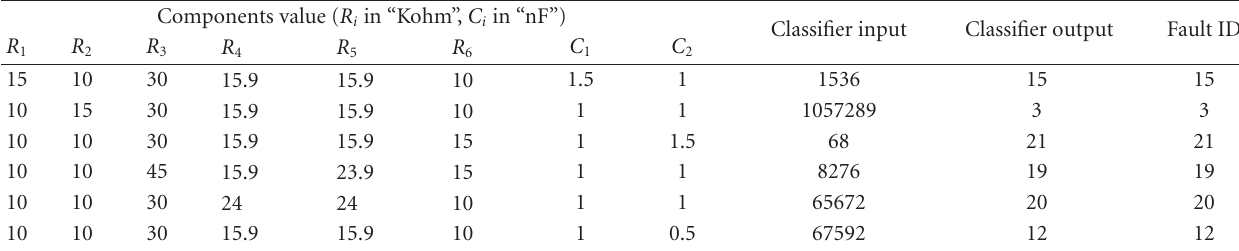
Table 9: Few tested patterns.